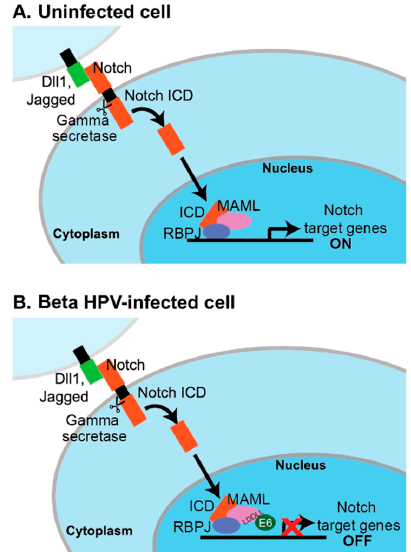
Figure 2. Genus beta HPV E6 bind MAML1 to inhibit NOTCH signaling. A schematic of activated NOTCH signaling in the absence ( A ) and presence ( B ) of genus beta HPV E6. Upon activation of the NOTCH signaling pathway, proteolytic cleavage of NOTCH releases the NOTCH intracellular domain (ICD), which can translocate to the nucleus. It displaces transcriptional repressors and forms